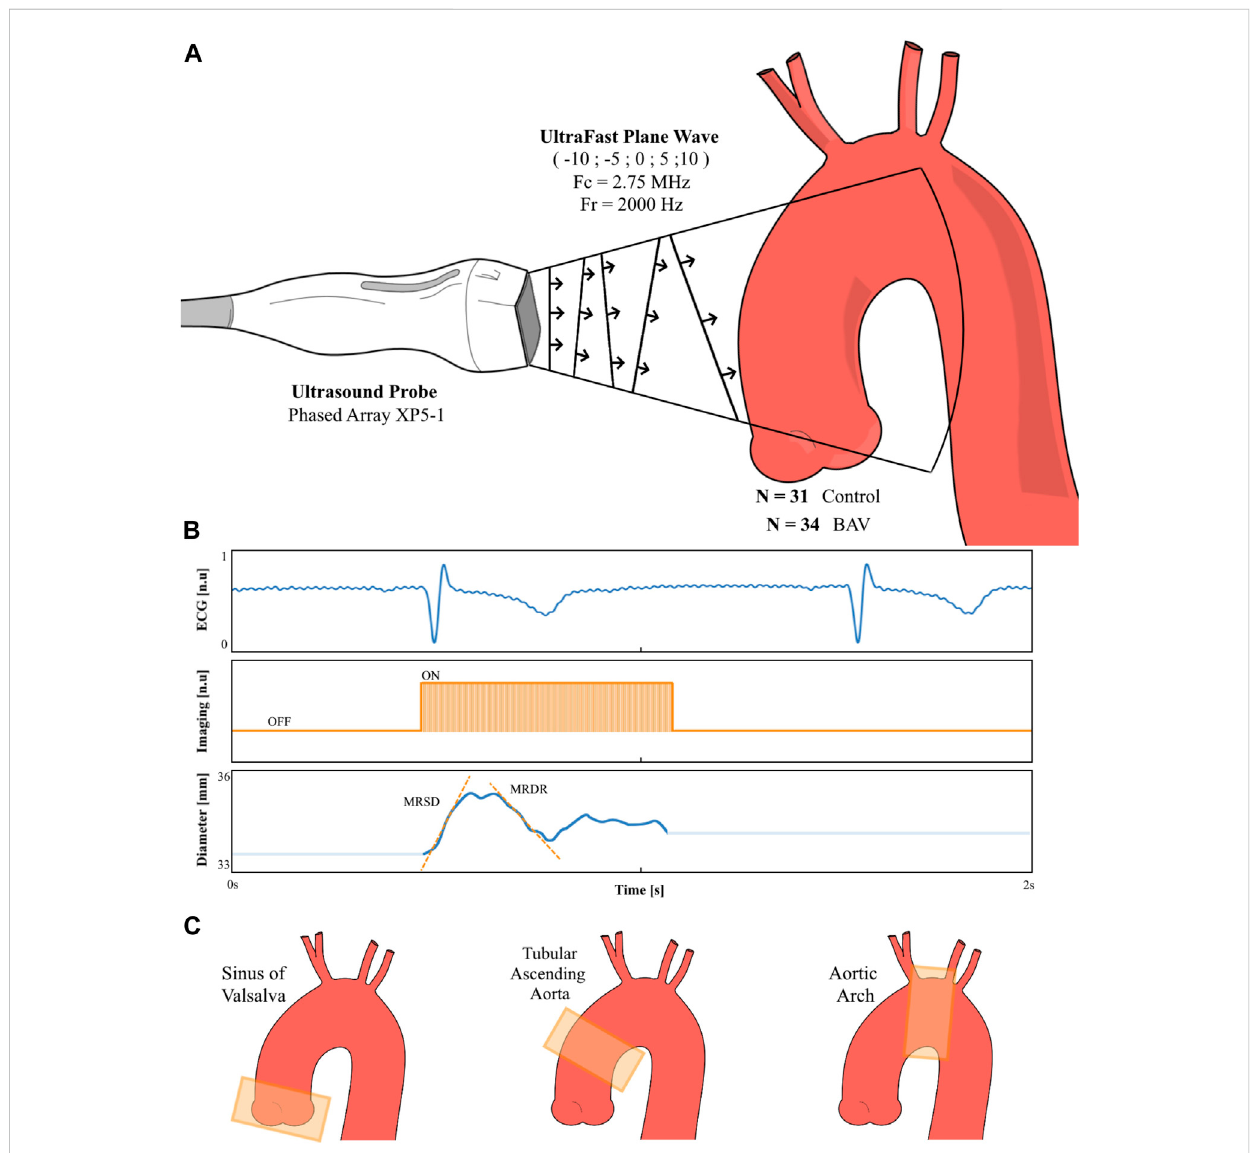
FIGURE 1 Technical methodology overview. A plane wave sequence with fi ve different angles have been adapted for a phased array probe (1 – 5 MHz frequency). Starting from a conventional B-mode ultrasound allowing the placement of the probe in front of the aortic segment to be imaged (A) , the plane ’ s waves ’ acquisition was launched at the foot of the QRS. The aortic Diameter is then recorded with the calculation of the Maximal Rate of Systolic Distension (MRSD) and Maximal Rate of Diastolic MRDR (B) . This procedure was repeated on three segments of the aorta (C) : sinus of Valsalva, tubular ascending aorta, and aortic arch; in 34 patients with bicuspid aortic valve (BAV) and 31 healthy relatives